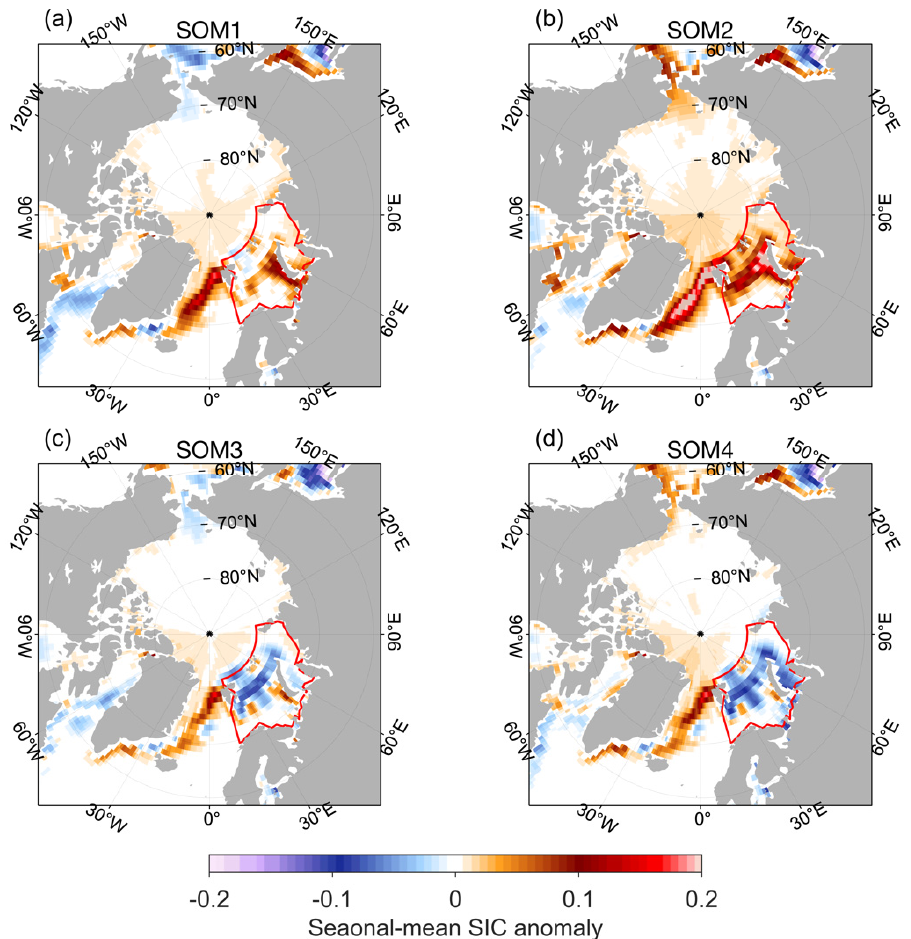
Figure 7. The same as Figure 5 except for the composites of the winter-mean SIC anomalies. The shaded area passes the p = 0.05 significance test. The four plots are SIC anomalies related to SOM1 ( a ), SOM2 ( b ), SOM3 ( c ), and SOM4 ( d